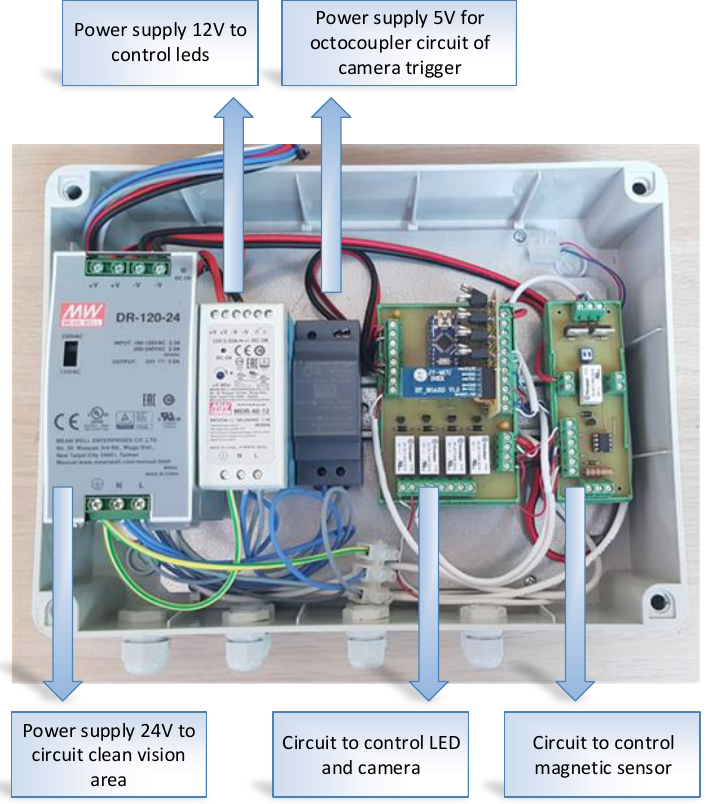
Figure 6. Electronic circuit of the external trigger and LED.